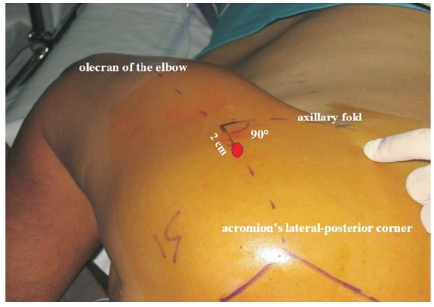
Figure 11: Checcucci technique for the axillary nerve block. A line is drawn between the posterolateral angle of the acromion and the olecranon tip of the elbow. The needle insertion is 2cm cephalad to the convergence of this line with the perpendicular line originating from the axillary fold (Checcucci et al. [4]). (Reprinted with permission from Elsevier.)